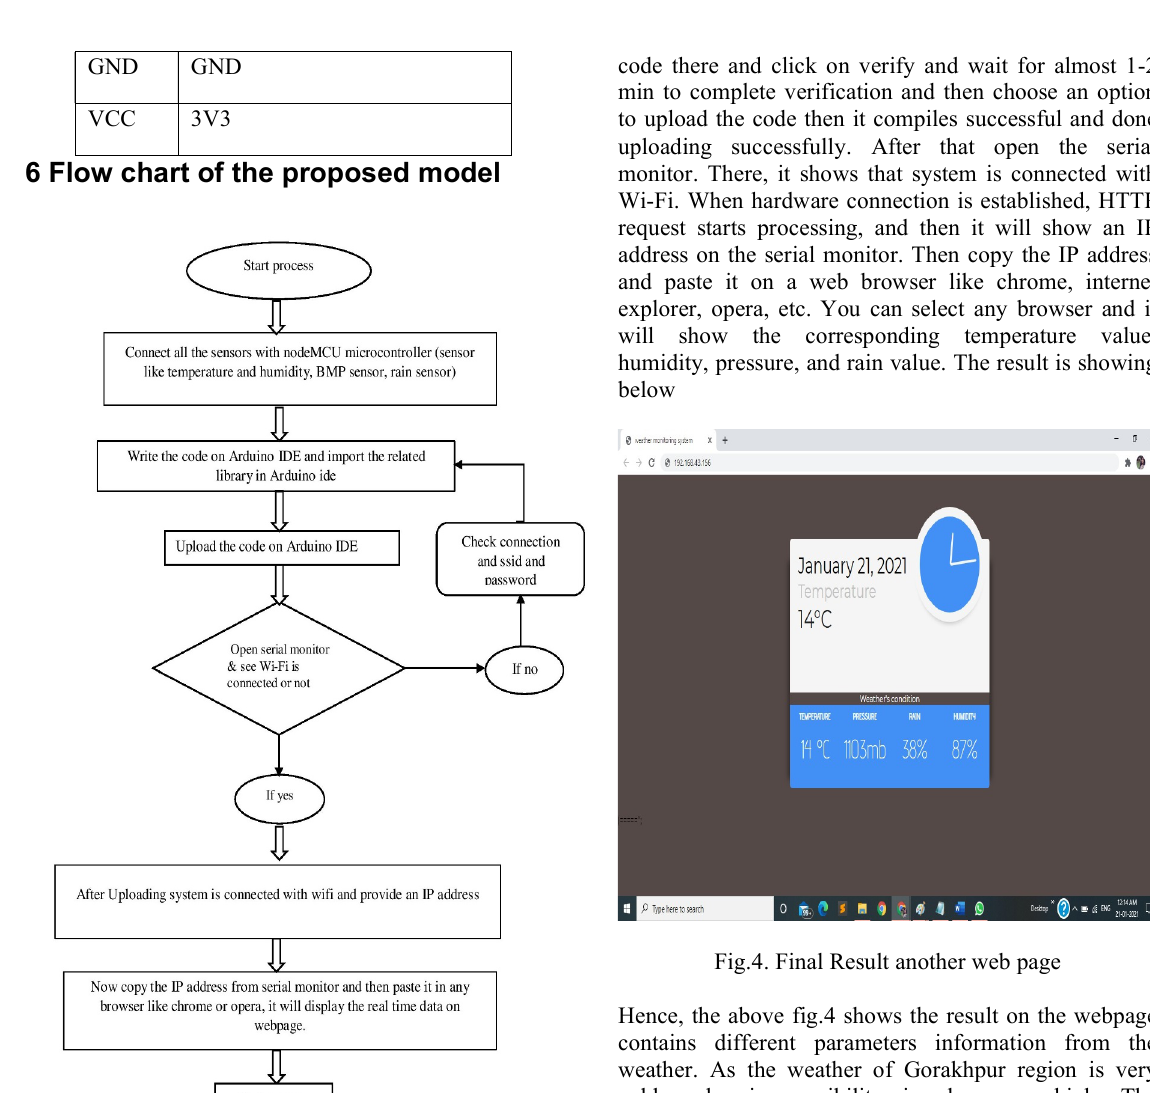
Fig.3. Flow chart of the proposed model